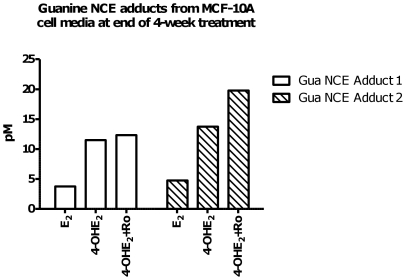
Biomarker study of guanine NCE adducts measured in supernatant of cells treated with E2 and catechol metabolites; guanine adducts correlate with transformation potency.Guanine NCE adducts of 4-OHE1 were measured in media from MCF-10A cells treated with: E2 1 µM, 4-OHE2 1 µM, or (4-OHE2 1 µM+Ro 3 µM) at week 4. These NCEs adducts were not detectable in vehicle control experiments. N7-Me-guanine (5 nM) was used as internal standard. MRM fragmentation patterns of NCEs (m/z→m/z) corresponded to: Gua NCE Adduct 1 4-OHE1-Gua (436→152); Gua NCE Adduct 2 4-OHE2-Gua adduct (438→152).